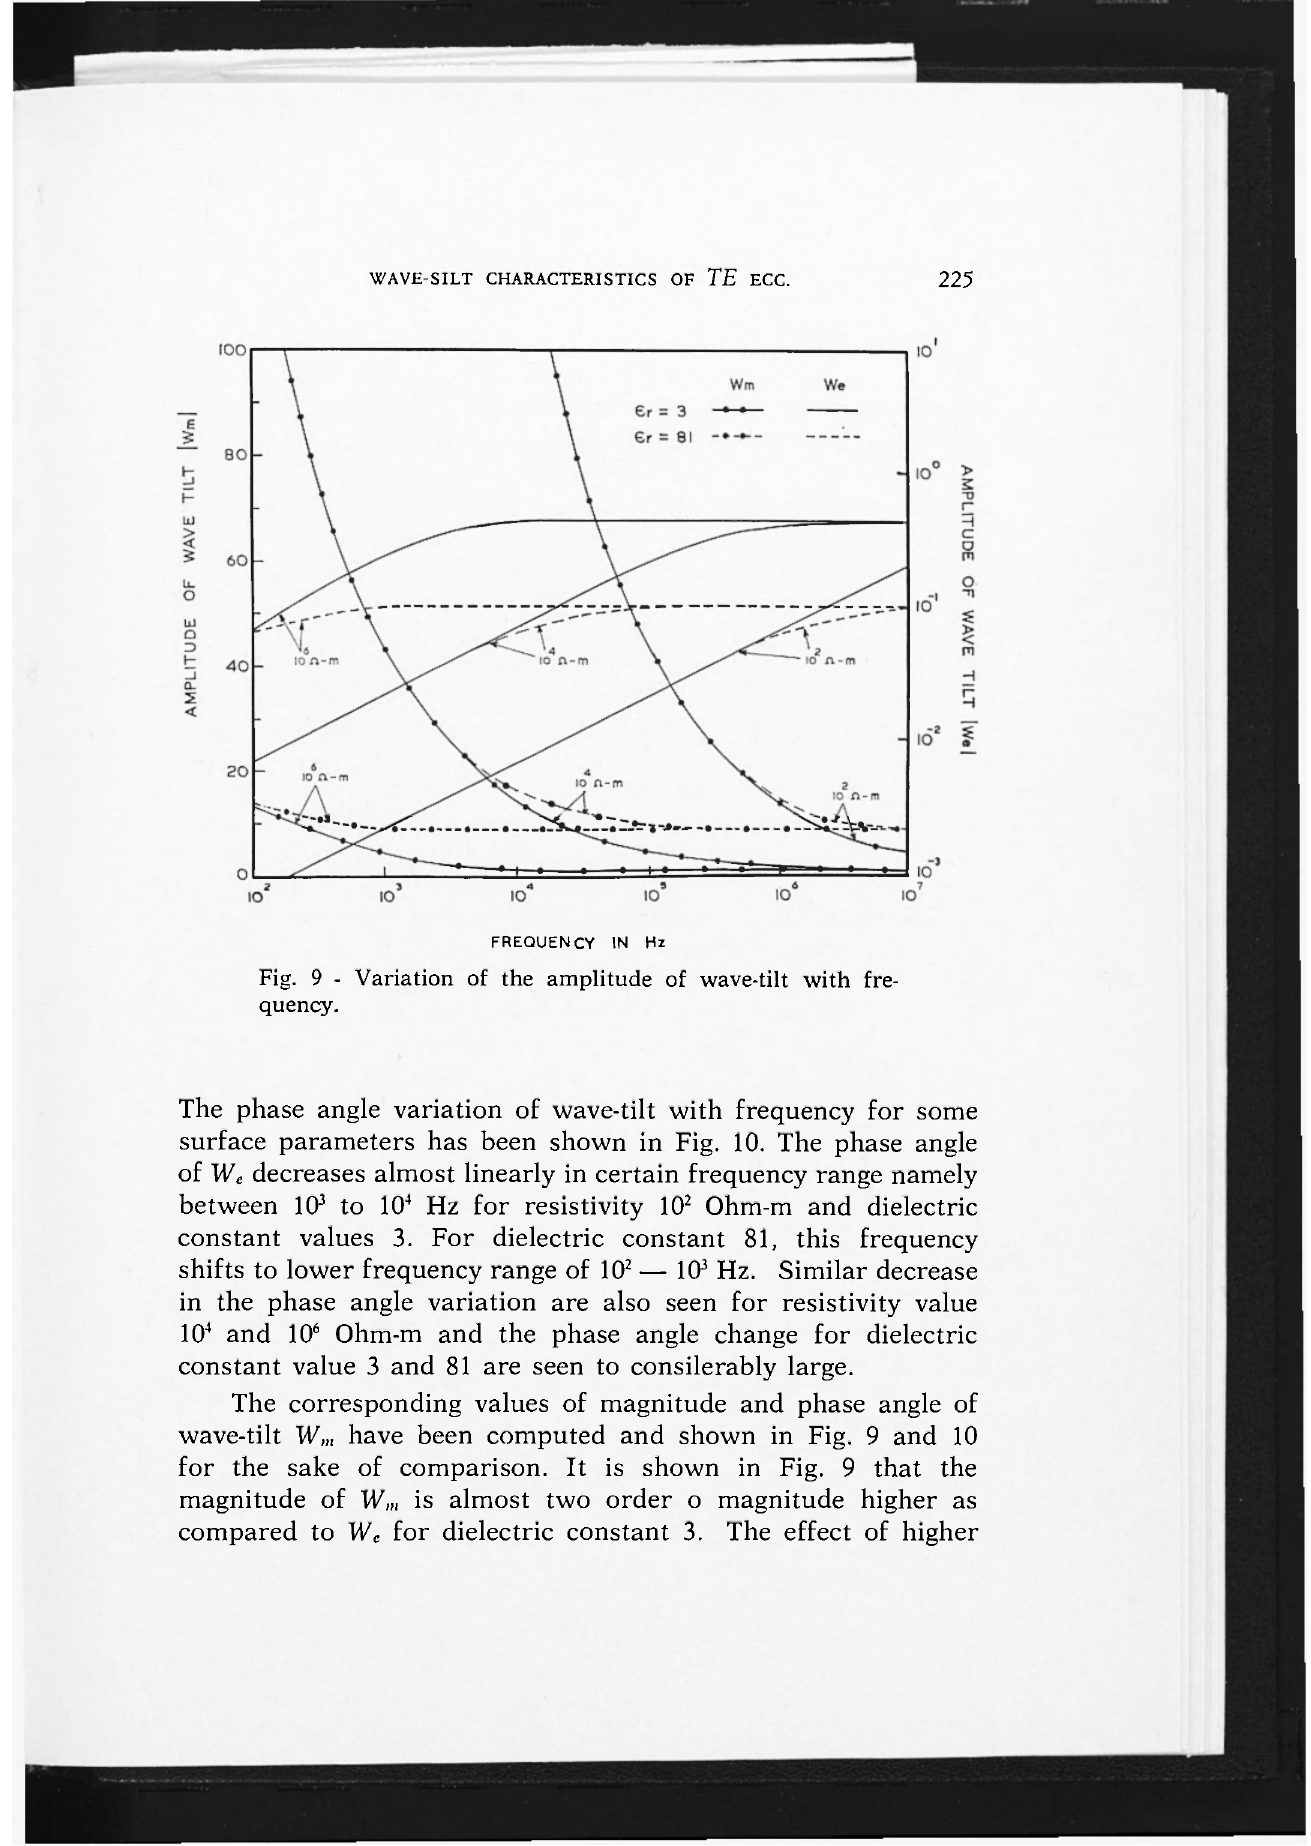
Fig. 9 - Variation of the amplitude of wave-tilt with fre-